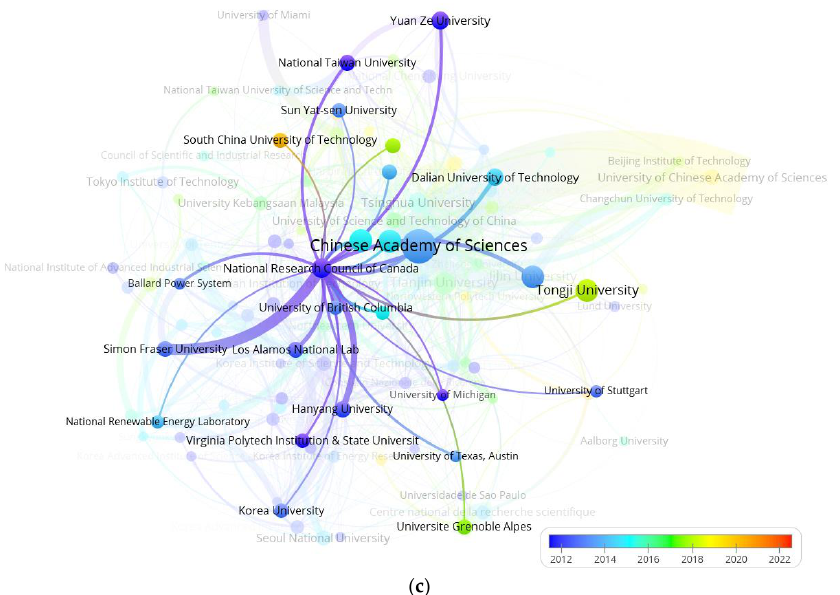
Figure 8. Map of the collaboration network of main institutions ( a ) the overall network ( b ) collaboration network with Chinese Academy of Sciences ( c ) collaboration network with National Research Council of Canada.